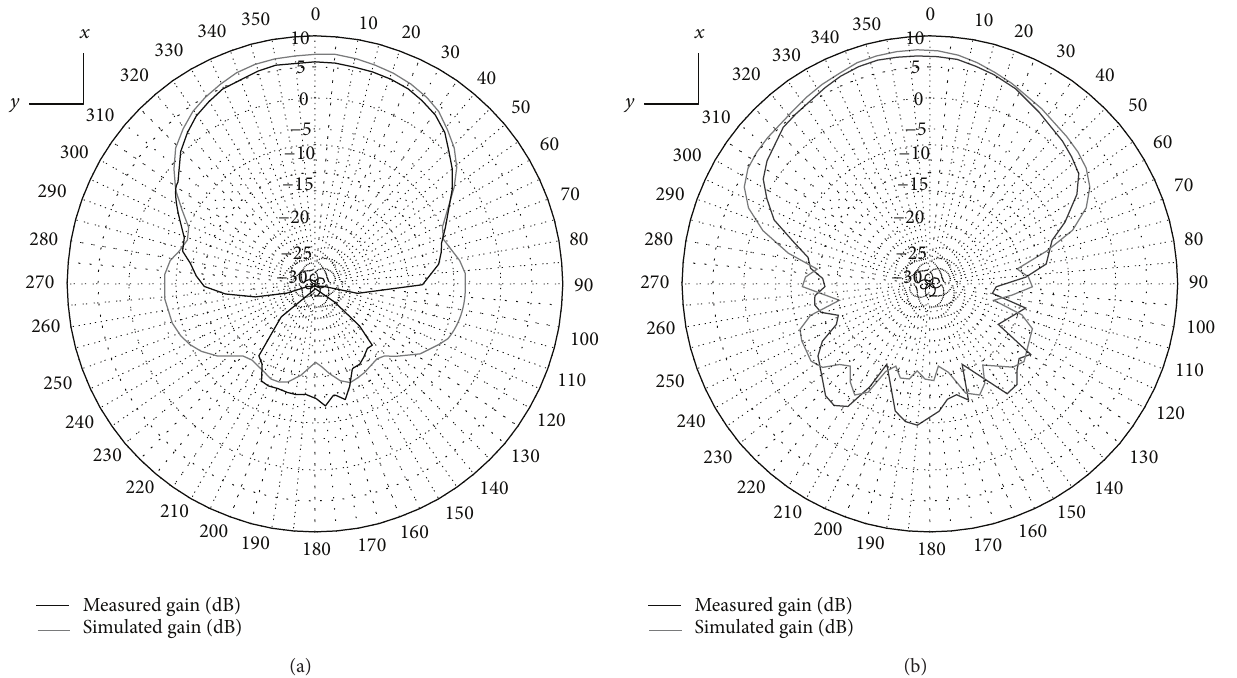
Figure 24: Measured and simulated radiation pattern at 5 GHz (a) and 10 GHz (b) of the first proposed planar directional UWB antenna